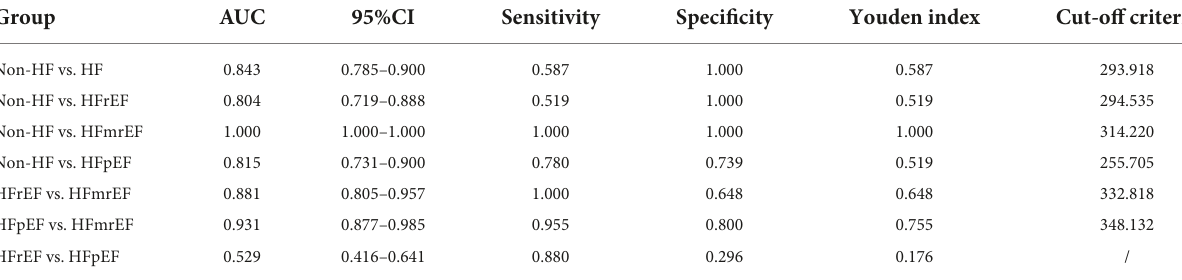
TABLE 4 Statistical analysis of ROC curve in identifying HF and each HF